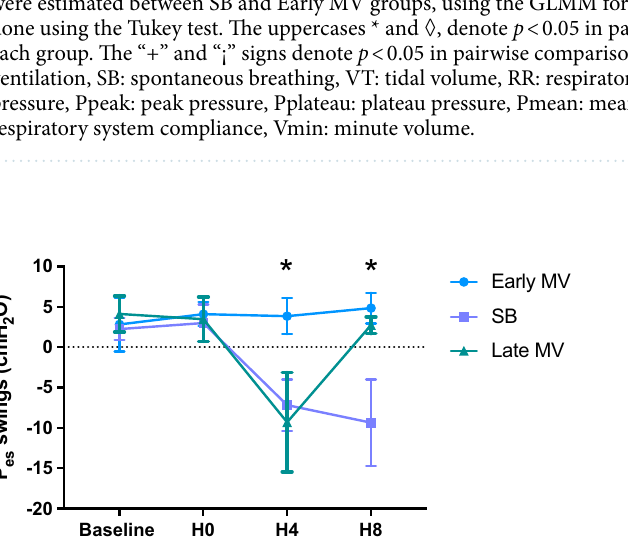
Figure 2. Changes in esophageal pressure swings over time in the three ventilatory groups. MV corresponds to mechanical ventilation, SB corresponds to spontaneous breathing, Pes corresponds to esophageal pressure. * p <